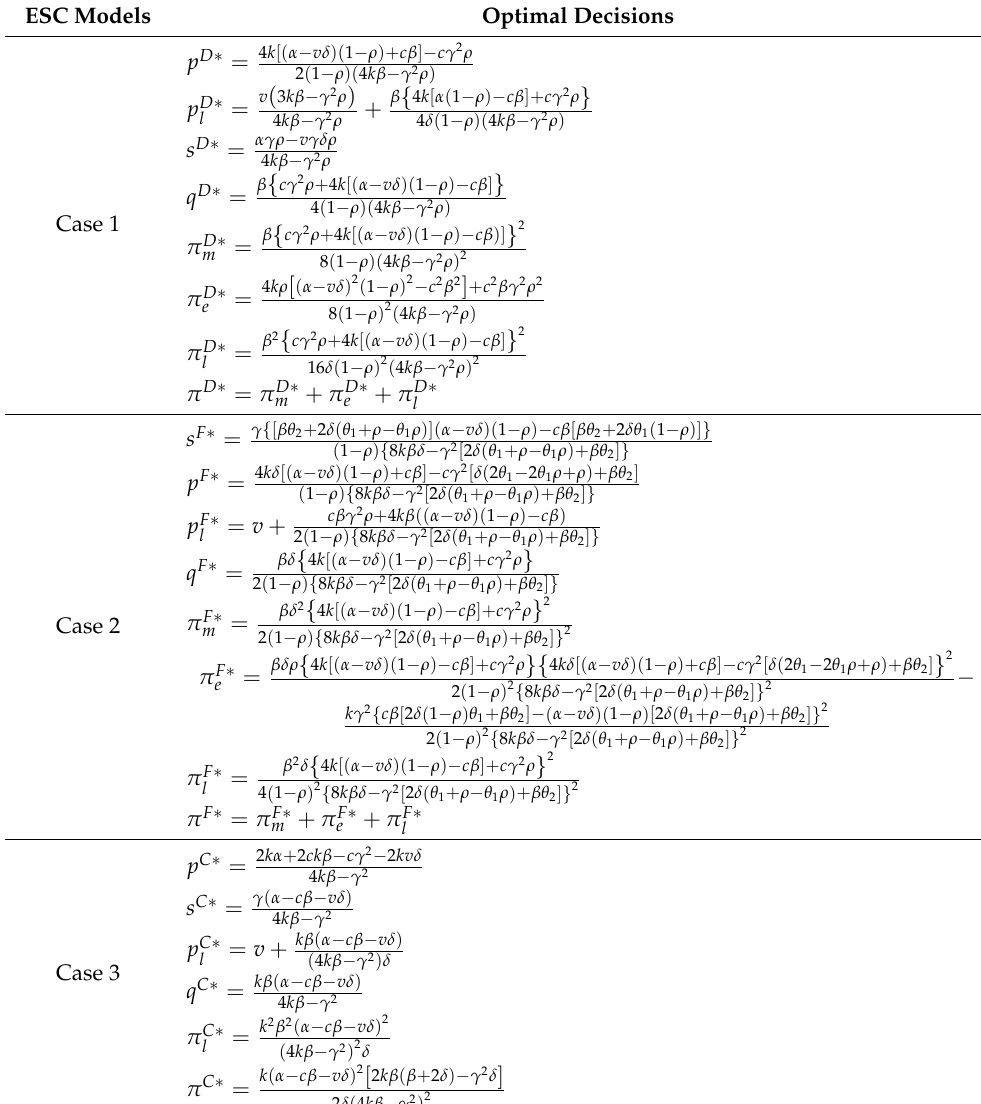
Table 3. Optimal decisions in different